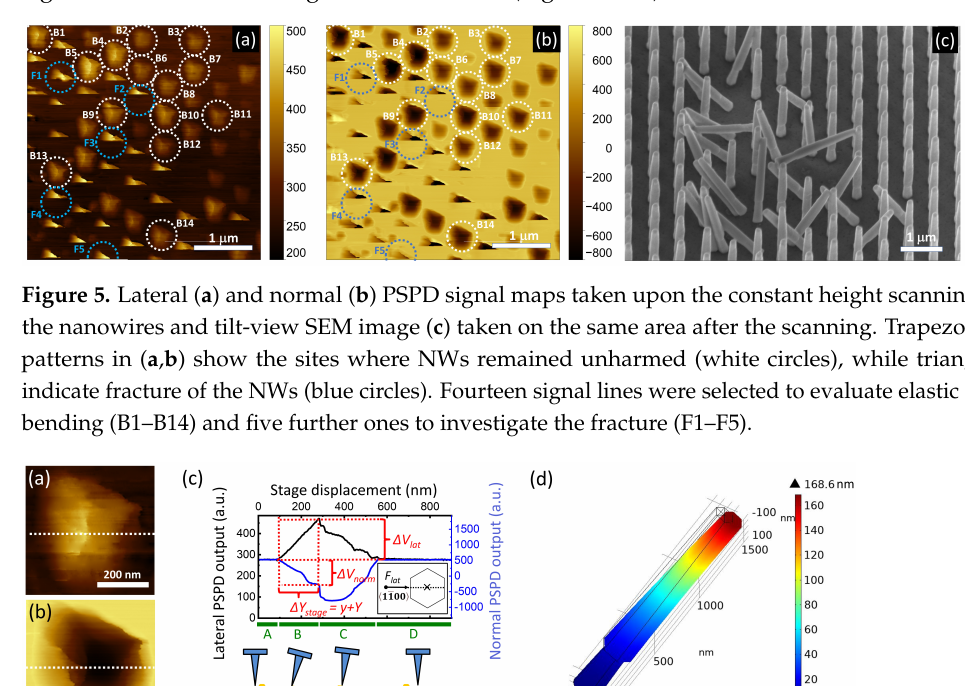
Figure 5. Lateral ( a ) and normal ( b ) PSPD signal maps taken upon the constant height scanning of the nanowires and tilt-view SEM image ( c ) taken on the same area after the scanning. Trapezoidal patterns in ( a , b ) show the sites where NWs remained unharmed (white circles), while triangles indicate fracture of the NWs (blue circles). Fourteen signal lines were selected to evaluate elastic NW bending (B1–B14) and five further ones to investigate the fracture (F1–F5).